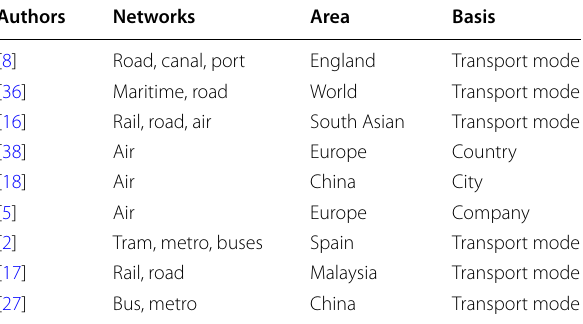
Table 1 Empirical studies of multilayer transportation networks by Zhan et